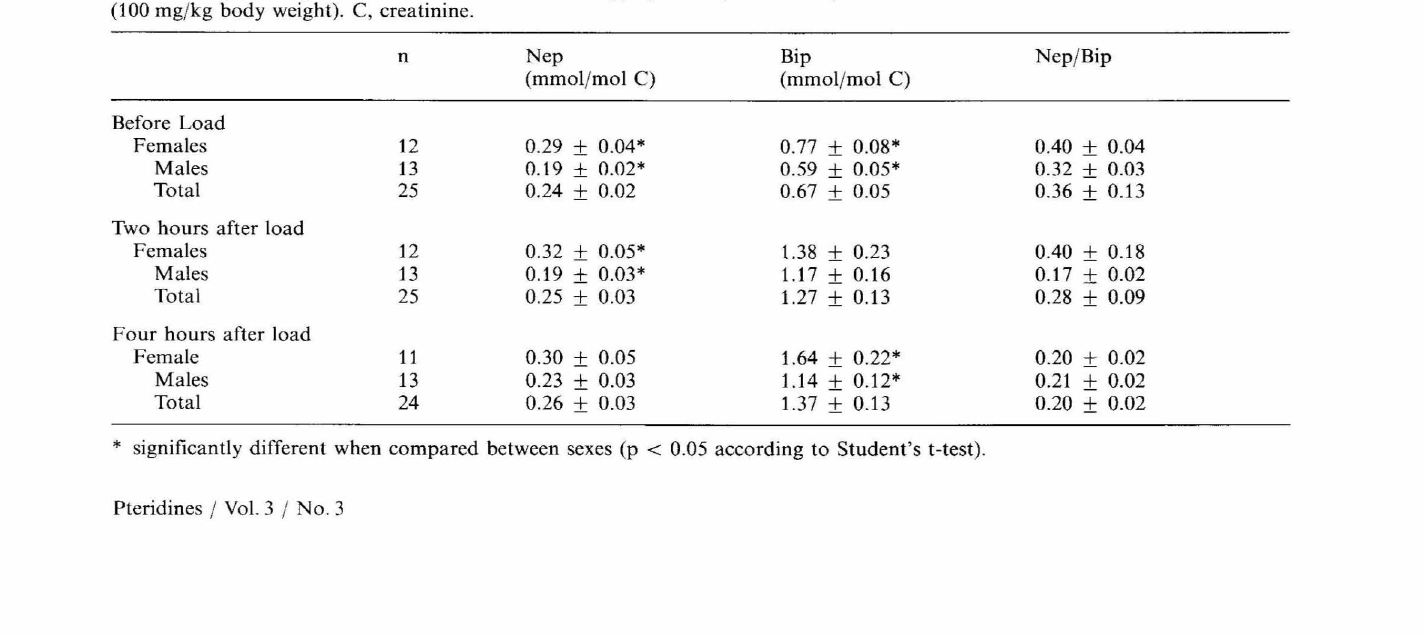
Table 1. Nep and Bip concentrations in urine and Nep/Bip ratio (mean ± SE) in normal controls, before and after a Phe load (100 mg/kg body weight). C,